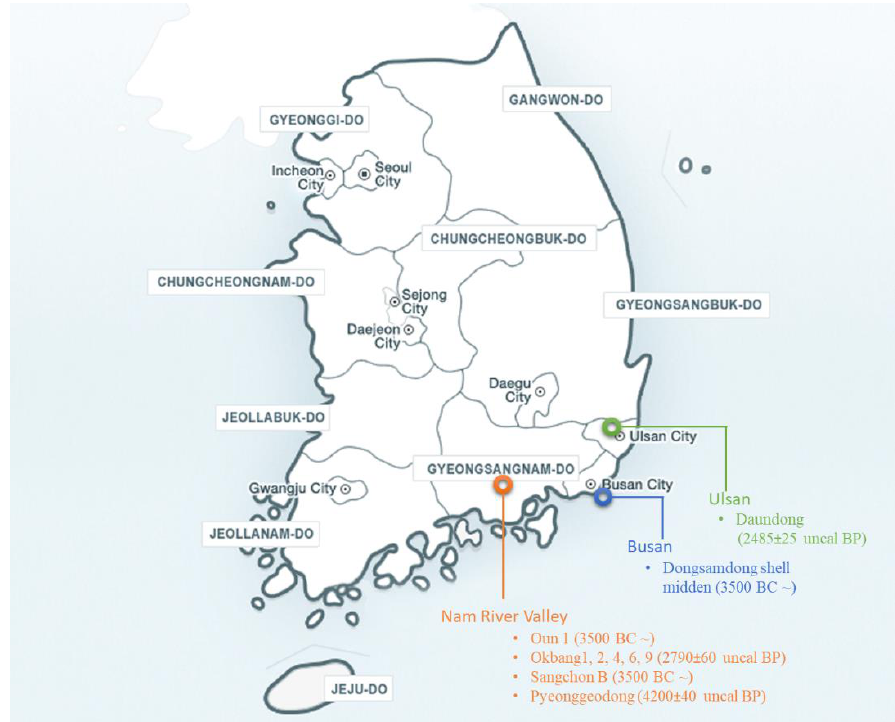
Figure 1. Map showing the archaeological sites of soybeans in South Korea. Bullets under each city show the names of the archaeological sites while the dates in brackets show the carbon dating information on charred soybean seeds. If there is no carbon dating of the soybean samples, then the reported chronological year is given [81,83] .